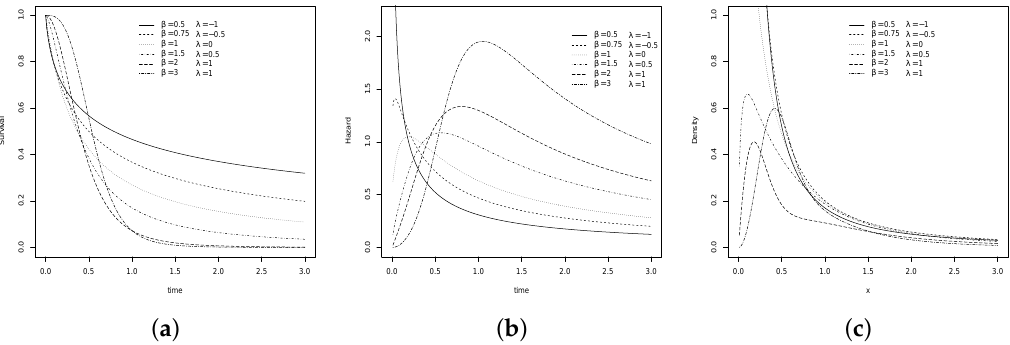
Figure 1. Transmuted model curves: ( a ) Survival, ( b ) hazard and ( c ) probability density